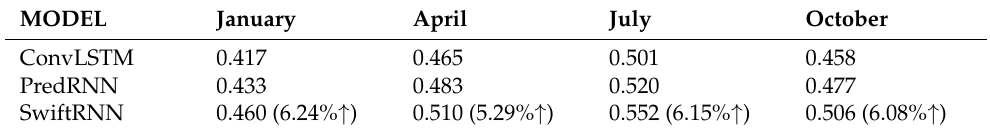
Table 6. Same with Table 5, but for CSI-4000 metric.